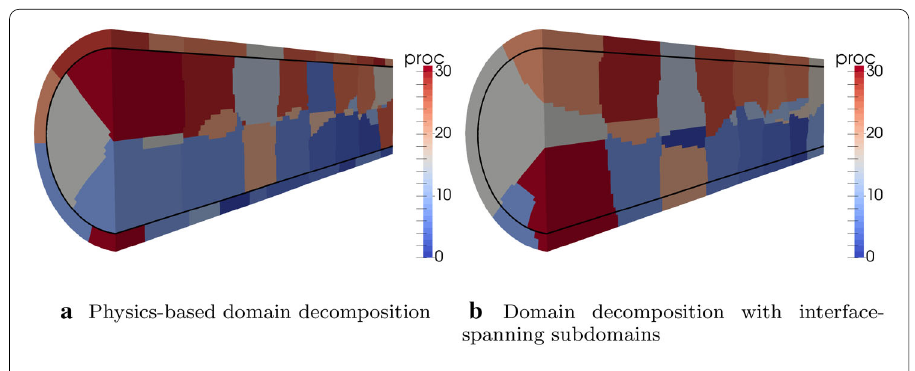
Fig. 6 The cut view illustrates the parallel distribution of the entire problem among 32 processes. Black lines indicate the interface position. Left: When solid and fluid domain have been distributed independently, subdomains do not span across the interface. Right: After redistribution based on a monolithic graph, some subdomains contain solid or fluid portions only, while a certain number of subdomains contains solid and fluid portions and span across the